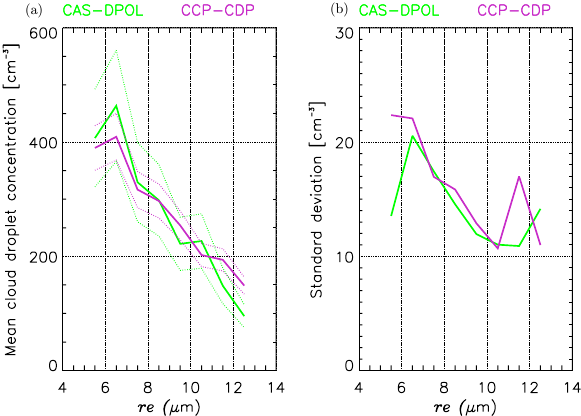
Figure 5. Mean cloud droplet concentrations for CAS-DPOL and CCP-CDP as a function of effective radius ( r e ) (a) . The systematic error for each probe is shown by the dashed line. (b) The standard deviation in cm − 3 of each probe concentration as a function of r e . The probes are identified by colors as shown at the top of the panels. The sample for each probe is the same as shown in Fig.